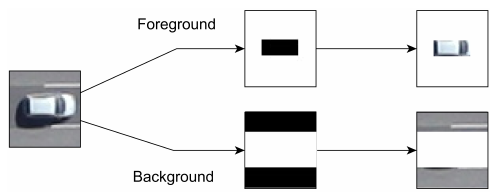
Figure 2: Foreground (potential car candidate) and background (potential street) can be set as a fixed area since the orientation of the cars is assumed to be known. The foreground is in the center of the patch while the background is restricted to the areas to the left and right of the car.